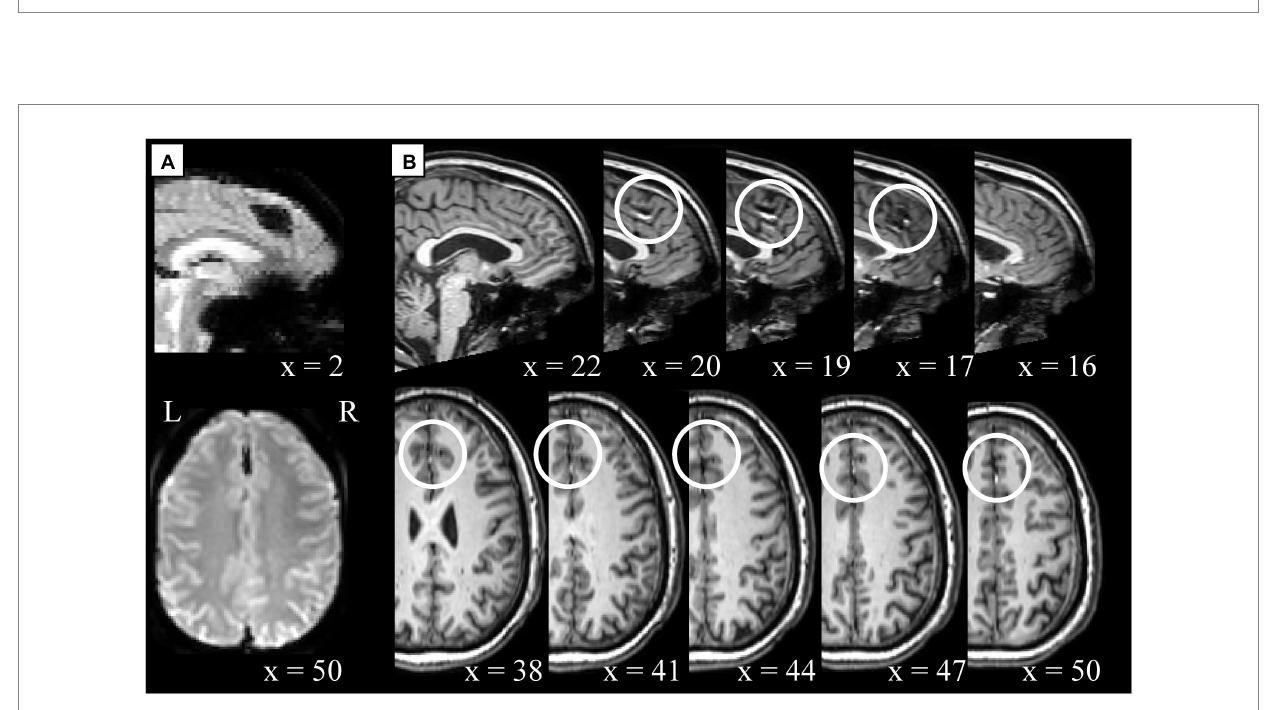
FIGURE 5 Example of cross-modality visual quality control for artifact characterization. Potential artifact of unspecified type in sub-315 (S55) functional (panel A ) and anatomical (panel B ) data. (A) Signal inhomogeneity affecting several axial slices localized in the interhemispheric fissure. The first scan is displayed here, however similar artifacts are noticeable across all scans. (B) Unspecified anatomical artifacts rendered in contiguous sagittal ( x = 22 to x = 16) and axial slices ( x = 38 to x = 50) in the top and bottom row, respectively. White circles indicate areas where artifacts are visible in a location comparable between functional and anatomical data. Note, the anatomical and functional images displayed here were in raw-level form, hence the spatial coordinates refer to subject-space and might differ across